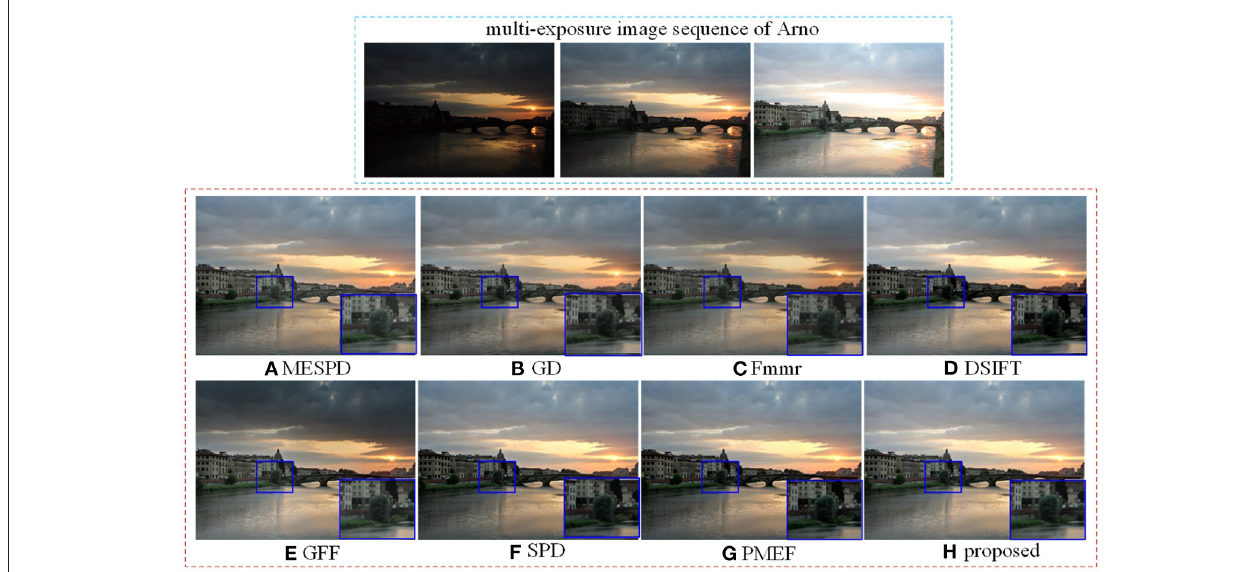
FIGURE 3 | Comparison of Arno scene experiment results of different methods.